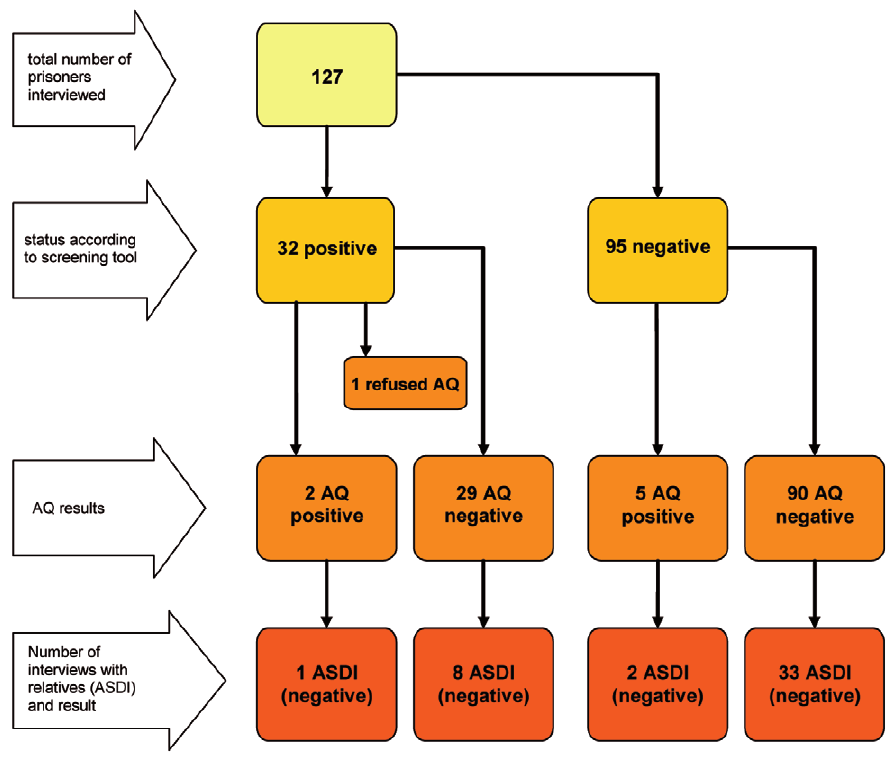
Table 5. Contingency table: screening tool results and AQ cut off.